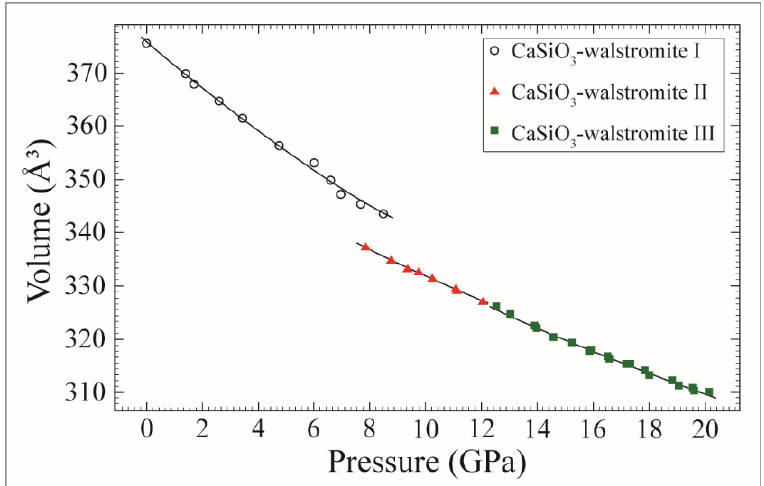
Figure 5. Evolution of the unit-cell volume with pressure of CaSiO 3 -walstromite. Unit-cell volume data of the two H P polytypes have been normalized to the low- P polytype. The solid line represents the 2nd order BM-EoS fit.